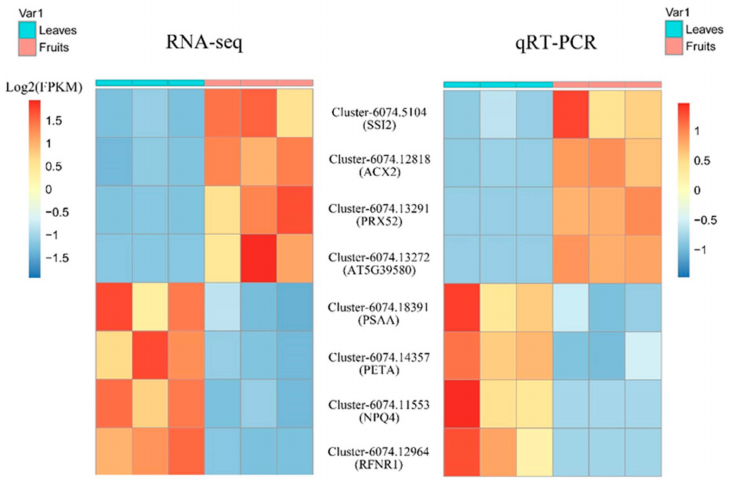
Figure 3. Validation of RNA-Seq results by qRT-PCR for eight U. pumila dysregulated genes. The expression of selected DEGs in fruits and leaves are shown. A red color indicates high expression for the gene in the fruit samples. Log 2 (FPKM) means Log 2 () value of FPKM for